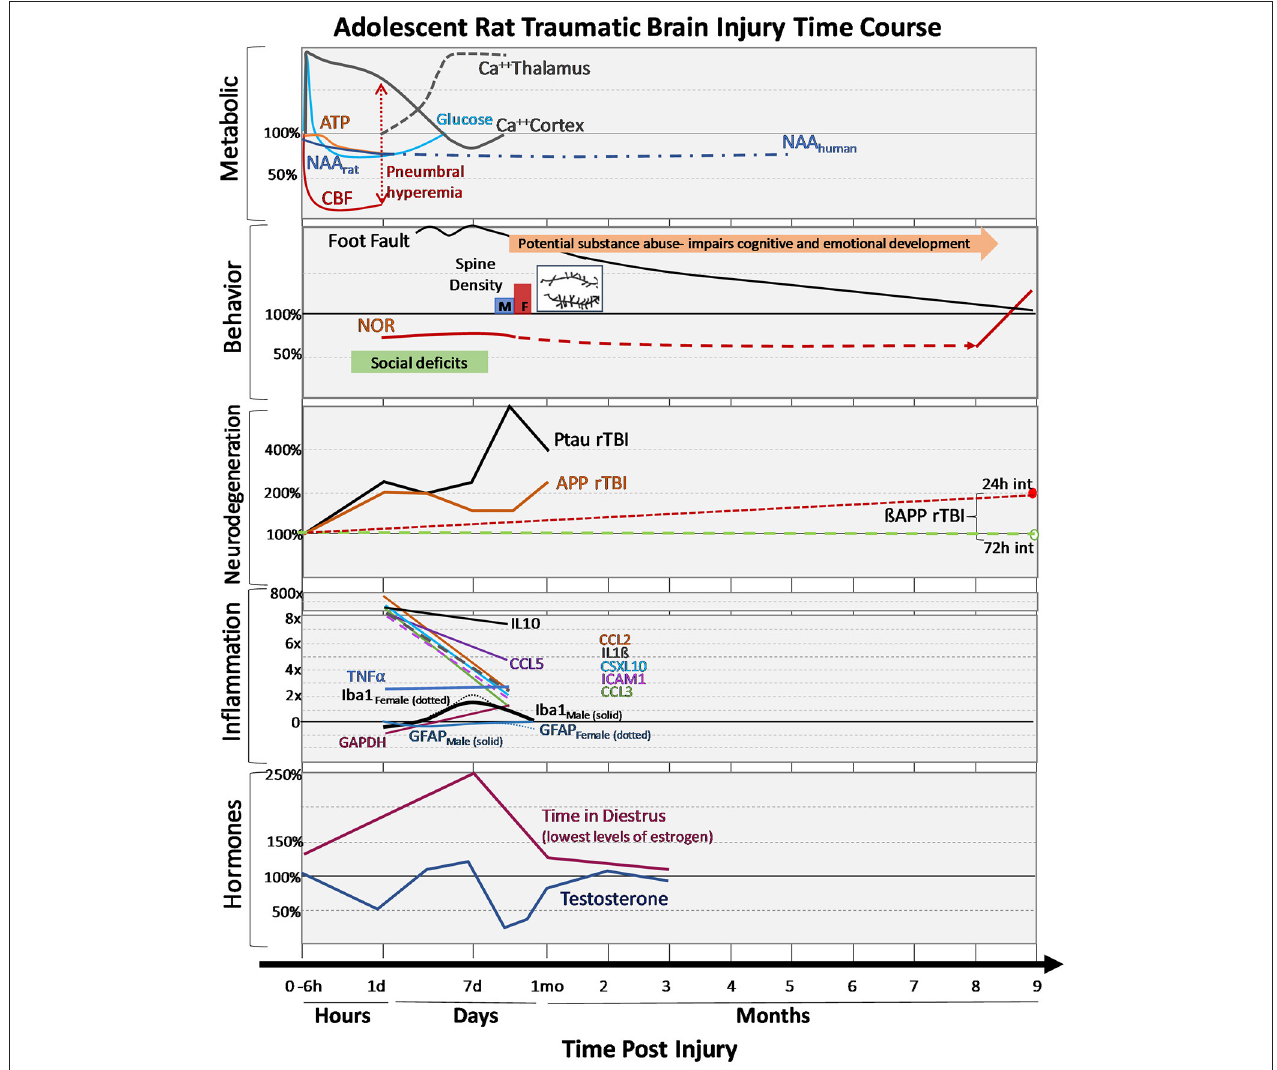
FIGURE 3 | Changes in outcomes after adolescent TBI. Changes in metabolism, behavioral performances, neurodegeneration markers, inflammatory cytokines and hormones after mild-moderate TBI during adolescence are expressed over hours, days, and months post-injury. Changes are expressed as percentages relative to adolescent sham values. Metabolic : early dynamic changes in glucose, cerebral blood flow (CBF) with tendency for hyperemia in younger brain, decreases in adenosine triphosphate (ATP) and N-acetylaspartate (NAA), as well as regionally dynamic changes in calcium accumulation as measured by 45 Ca ++ accumulation. Behavior: Adolescent motor deficits (foot faults) and cognitive (novel object recognition, NOR) deficits recovery can be prolonged recovery, additional stressors like substance abuse can further impair cognitive/emotional recovery, social deficits observed early after injury and the normal process of synaptic pruning (i.e., failure to prune) after injury (spine density: M-males, F-females, with insert showing the post-TBI increase in branching and synapses). Neurodegeneration: Following repeat TBI (rTBI), there are acute changes in phosphorylated tau (PTau) and amyloid precursor protein (APP) after injuries. Long-term differences in ßAPP between 24 and 72h injury intervals are observed in transgenic APP rats. Inflammation : Changes in numerous cytokines are shown along with glial fibrillary acidic protein (GFAP, red line), an astrocyte marker in males (solid) and females (dotted), ionized calcium-binding adaptor molecule-1 (Iba-1, black line) a microglia marker in males (solid) and females (dotted). Hormones: changes in sex hormones after TBI are shown for males and